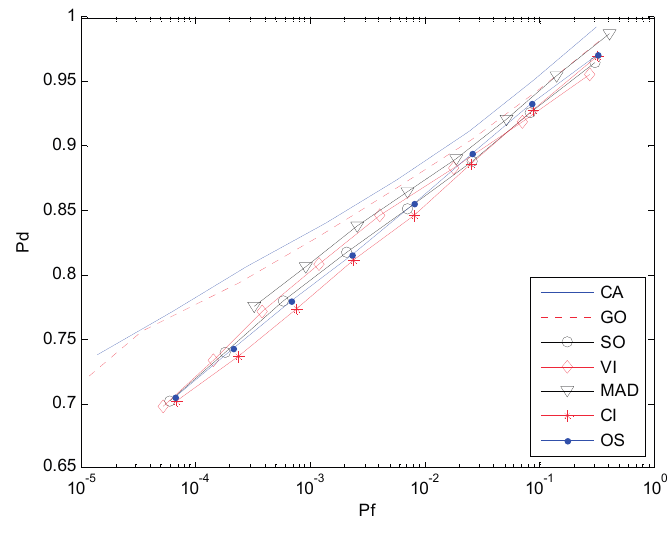
vs . P (ROC) in homogeneous d f